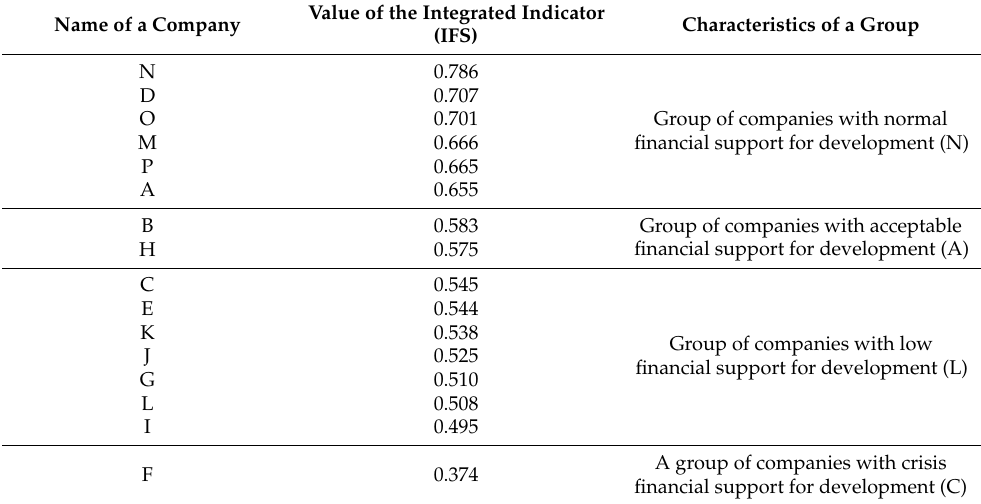
Table 4. Diagnosis of the state of financial support for the textile enterprises development.